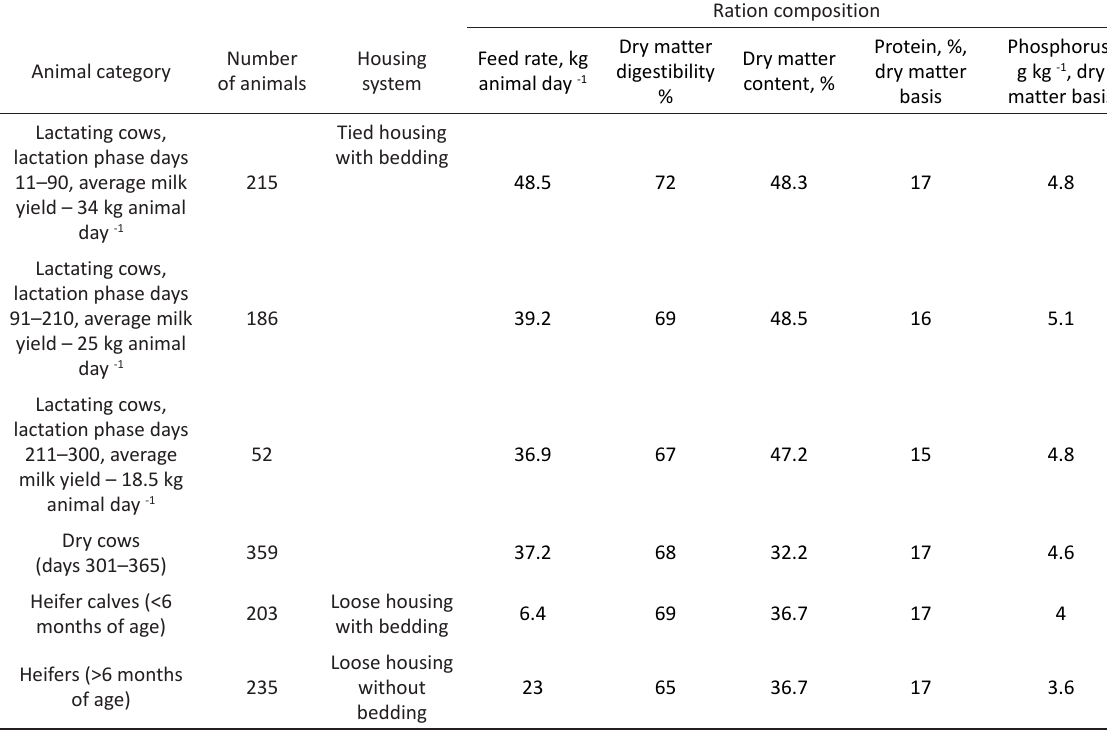
Table 2. Initial data provided by the cattle complex selected for the study